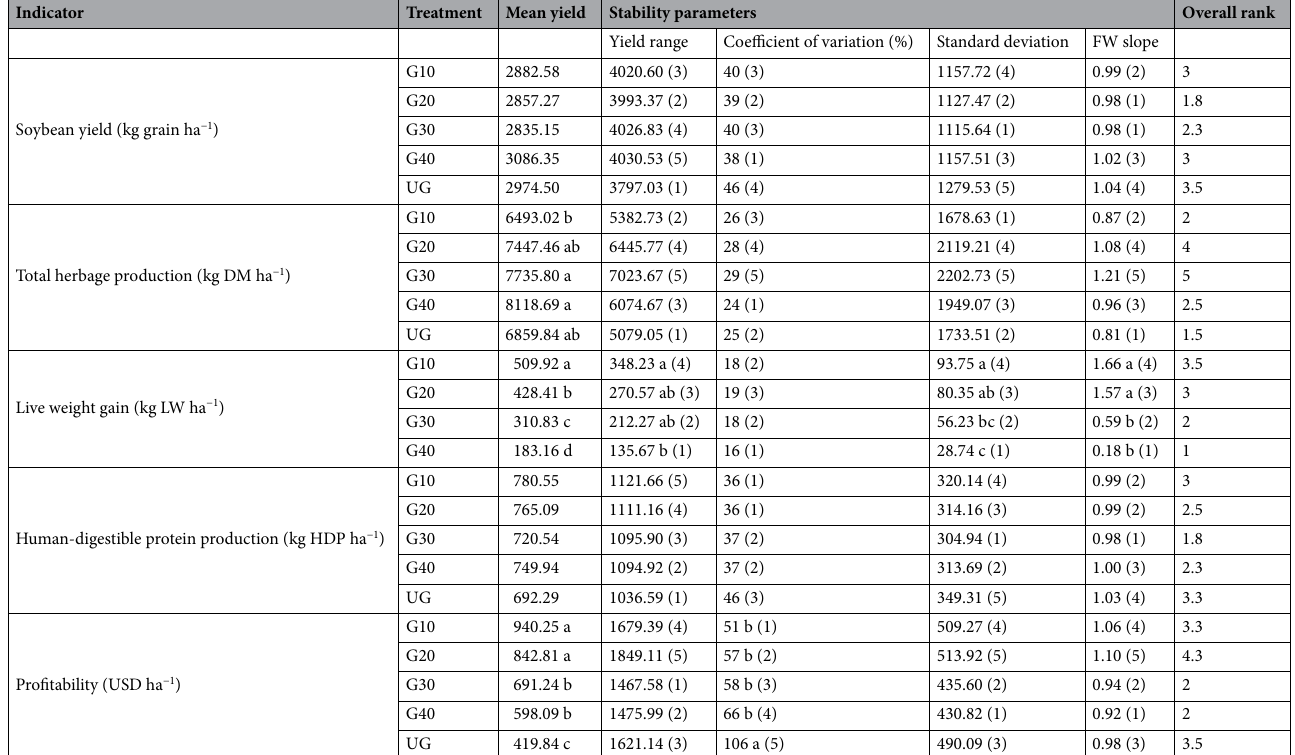
Table 1. Mean yields and stability parameters of a long-term (2001–2016) soybean system integrated with livestock at different grazing intensities or left ungrazed in the winter period. G10: intense grazing (10 cm sward height); G20: moderate grazing (20 cm sward height); G30: moderate-light grazing (30 cm sward height); G40: light grazing (40 cm sward height); UG: ungrazed cover crop. FW slope represents the Finlay and Wilkinson regression slope. Numbers in parentheses rank the treatments for each variable within each column. Different letters in the column represent significant differences among treatments according to the Tukey test ( ⍺ =